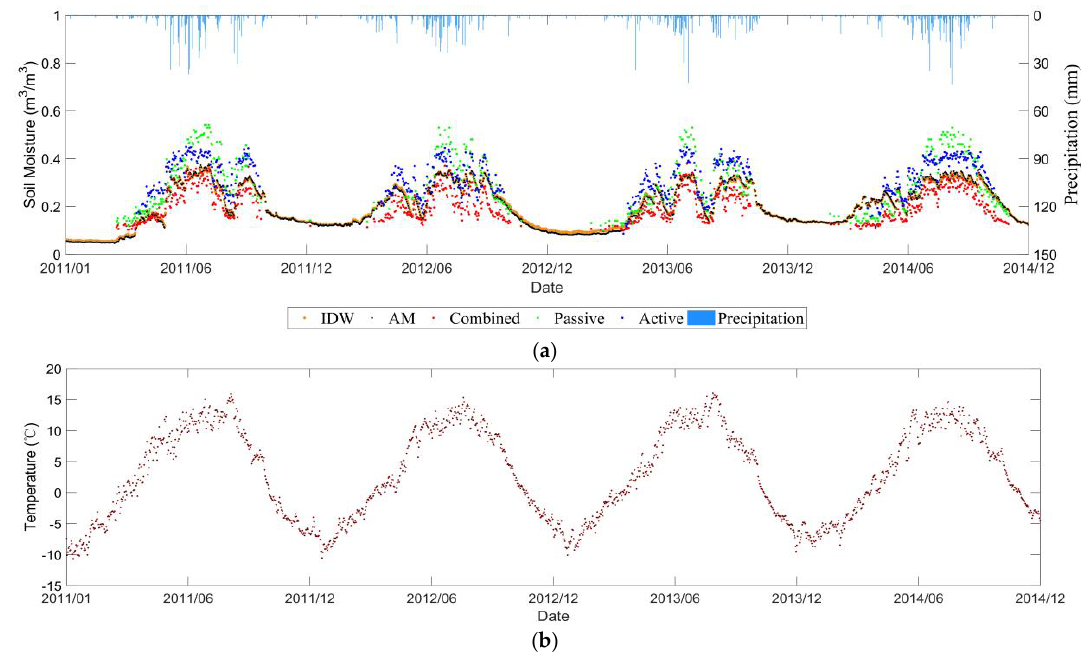
Figure 6. Temporal evolutions of ( a ) Climate Change Initiative (CCI) retrieved and in-situ measured soil moisture ( b ) temperature in the Central Tibetan Plateau Soil Moisture/Temperature Monitoring Network (CTP-SMTMN) network.